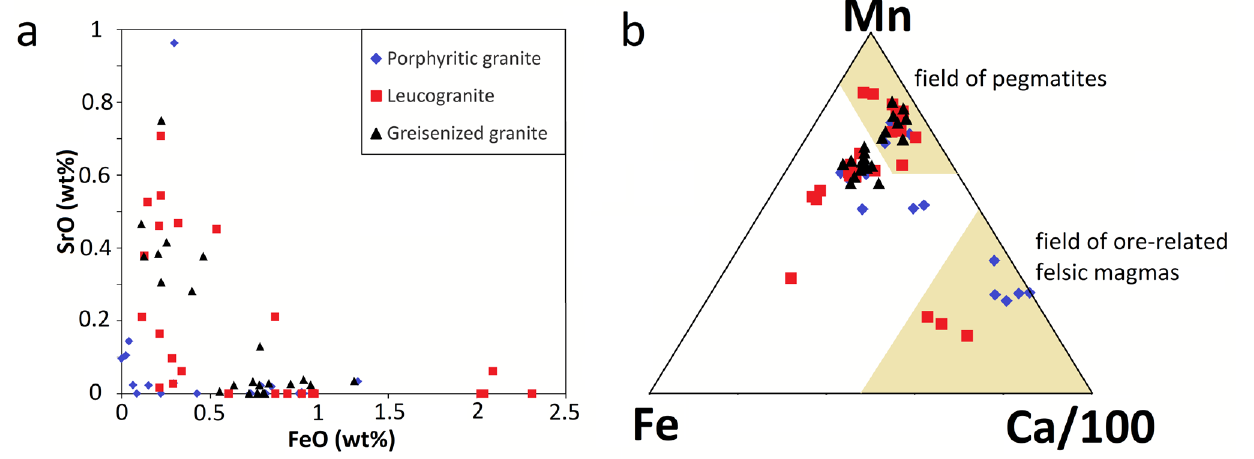
Figure 11. Chemical composition of apatite: ( a ) FeO vs. SrO; ( b ) a ternary diagram Ca/100–Mn–Fe (atomic proportions) according to [41]. Table 6. Chemical composition (wt.%, EMPA) and empirical formulae of apatite. All Ce-values below detection limit (bdl) of 0.03 wt. % Ce 2 O 3 .